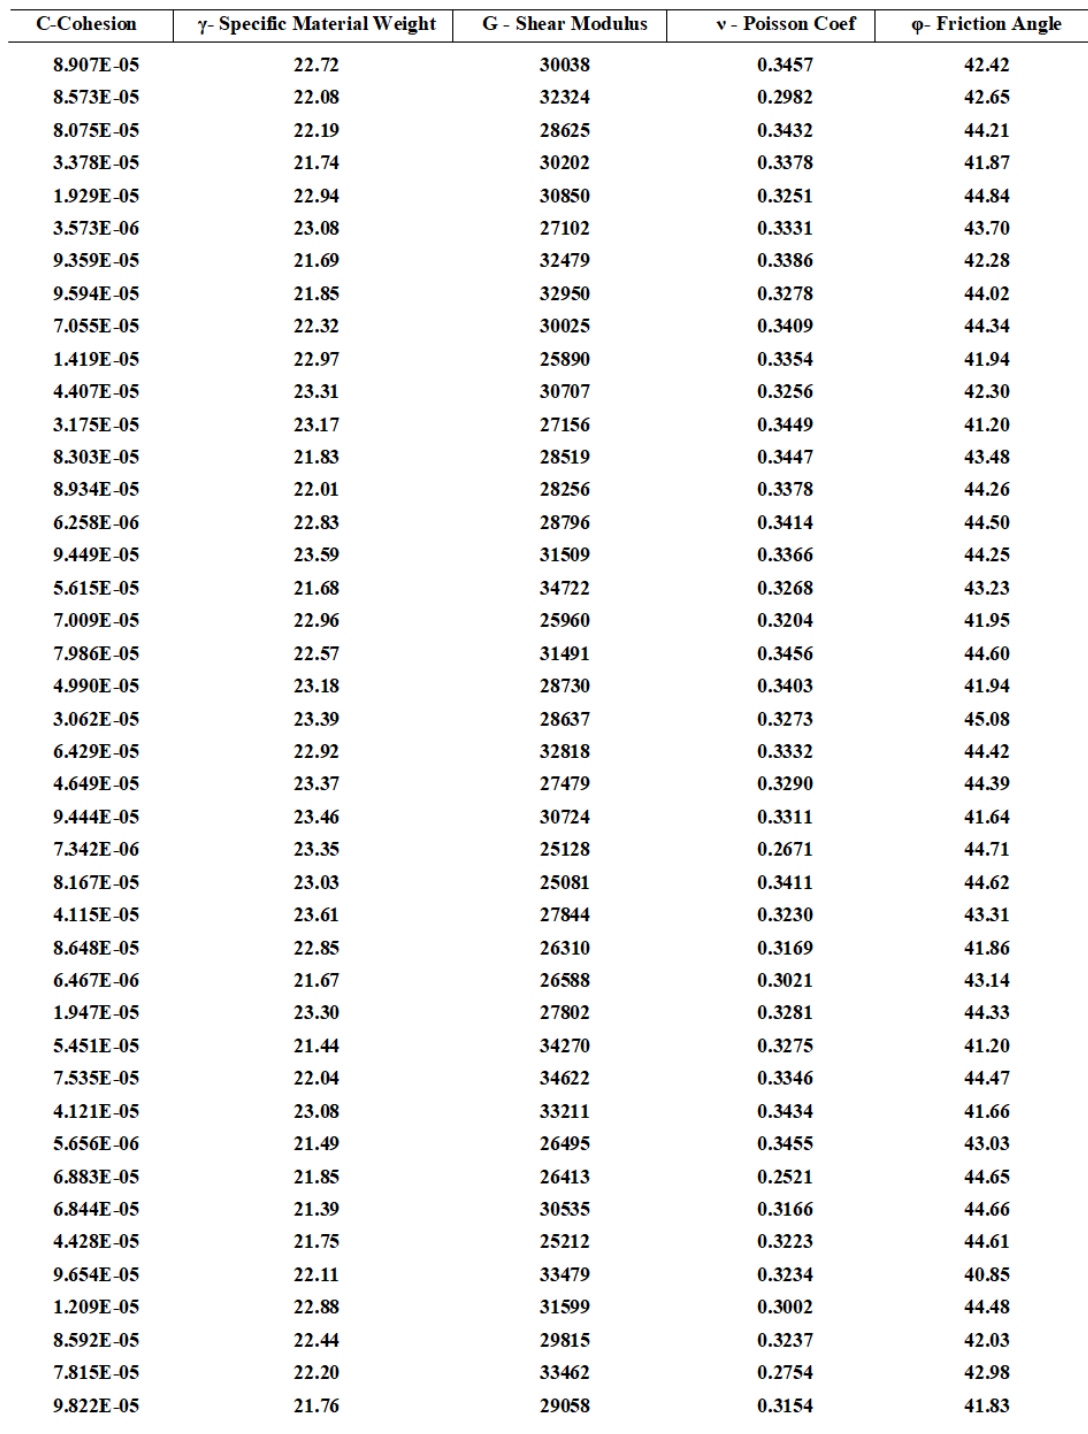
Figure A1. Sample points generated by the Sobol LDS approach for zone P. Units: Cohesion—kN/m 2 ; Sp. Material Weight—kN/m 3 ; Friction angle—Degree; Shear modulus—kN/m 2 .